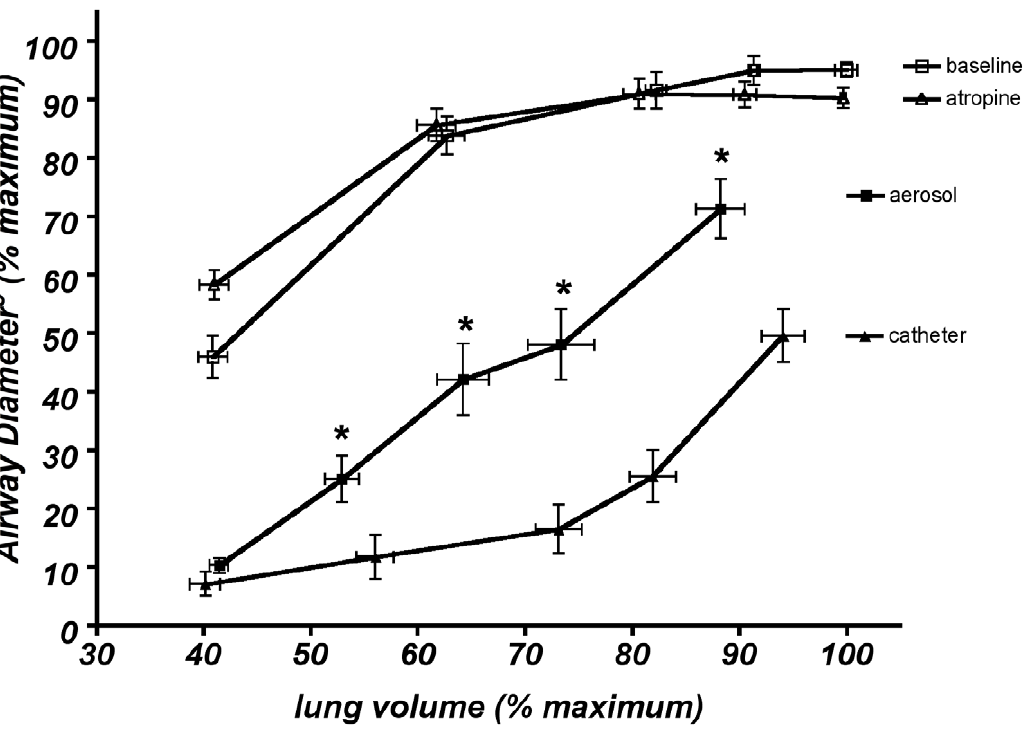
Figure 4. The relation between mean ( ± SEM) lung volume (as a percentage of the maximum lung volume) and mean ( ± SEM) airway diameter cubed. Both variables were measured at the five airway pressures (0, 12, 25, 32, and 45 cm H 2 O) under the four conditions: baseline (before aerosol, open squares), atropine (before catheter, open triangles), aerosol histamine challenge (black squares), and individual airway catheter challenge (black triangles). Airway diameter cubed is substantially and significantly less dependent on lung volume with the local catheter challenge significantly with airway pressure (p , 0.001) at all lung volumes above FRC (0 cm H 2 0 Paw).